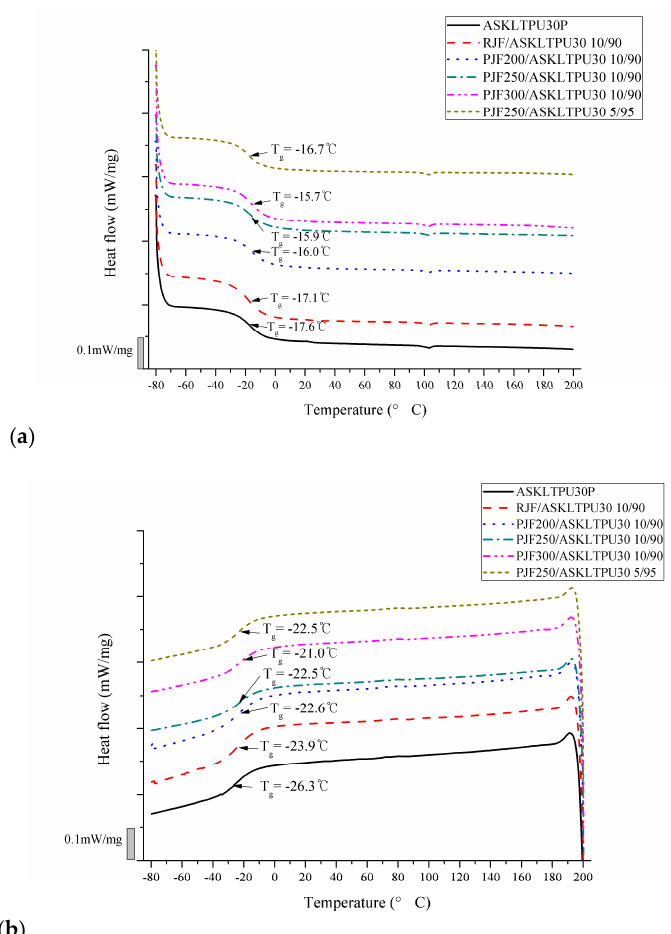
Figure 7. DSC thermograms of ASKLTPU30P and JF-reinforced ASKLTPU30: ( a ) the second heating curve; and ( b ) the first cooling curve.